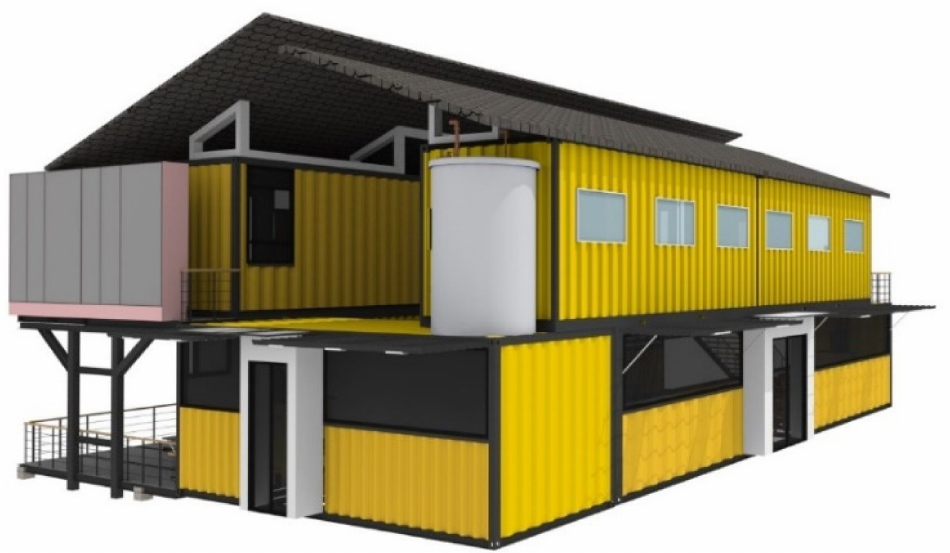
Figure 14. A passive design case for a school in Addis Ababa,